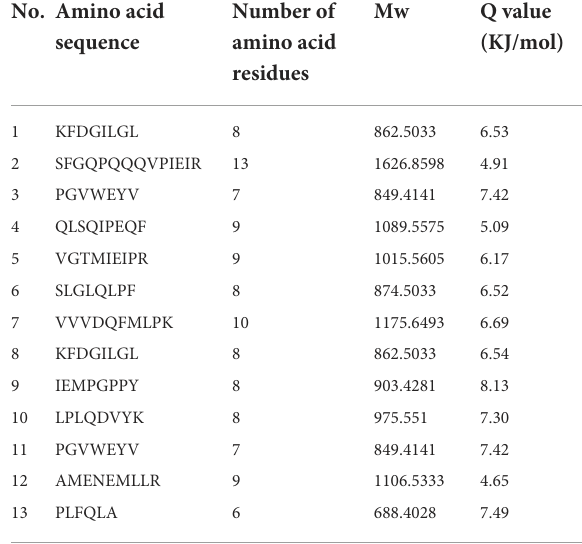
TABLE 7 Result of peptides sequence of WGH-Try12M determined by HPLC-MS/MS.